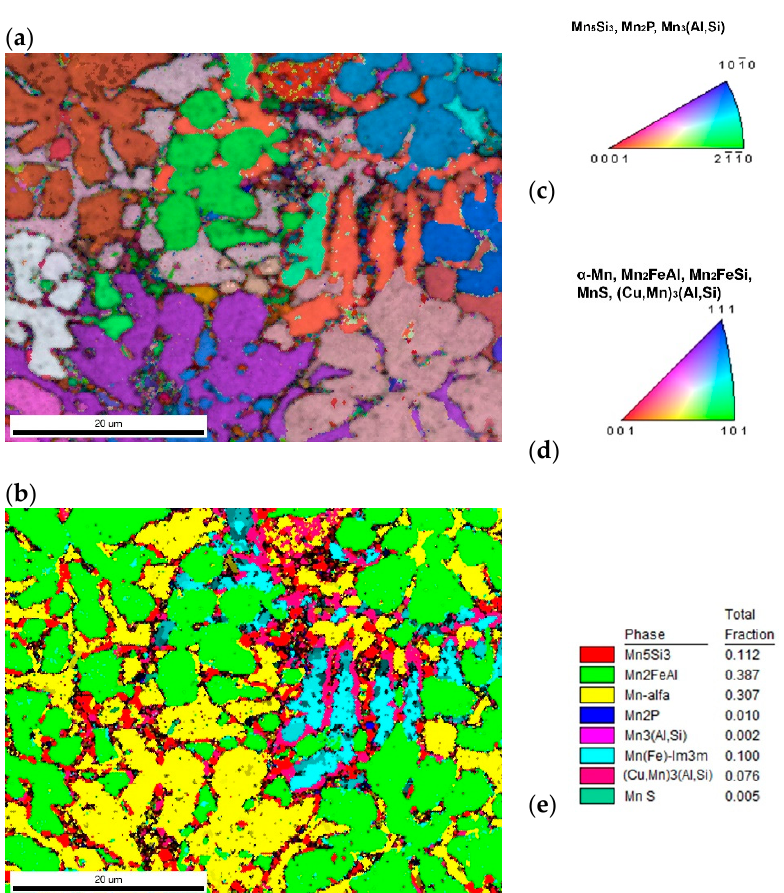
Figure 7. The sample with 20% excess of aluminum ( a ) inverse pole figure (IPF) map overlayed on a greyscale Image Quality map; ( b ) phase distribution overlayed on a greyscale Confidence Index map, whose color code and percentage of area coverage are given in ( e ). Colorized legends of particular phases are in ( c – d ).